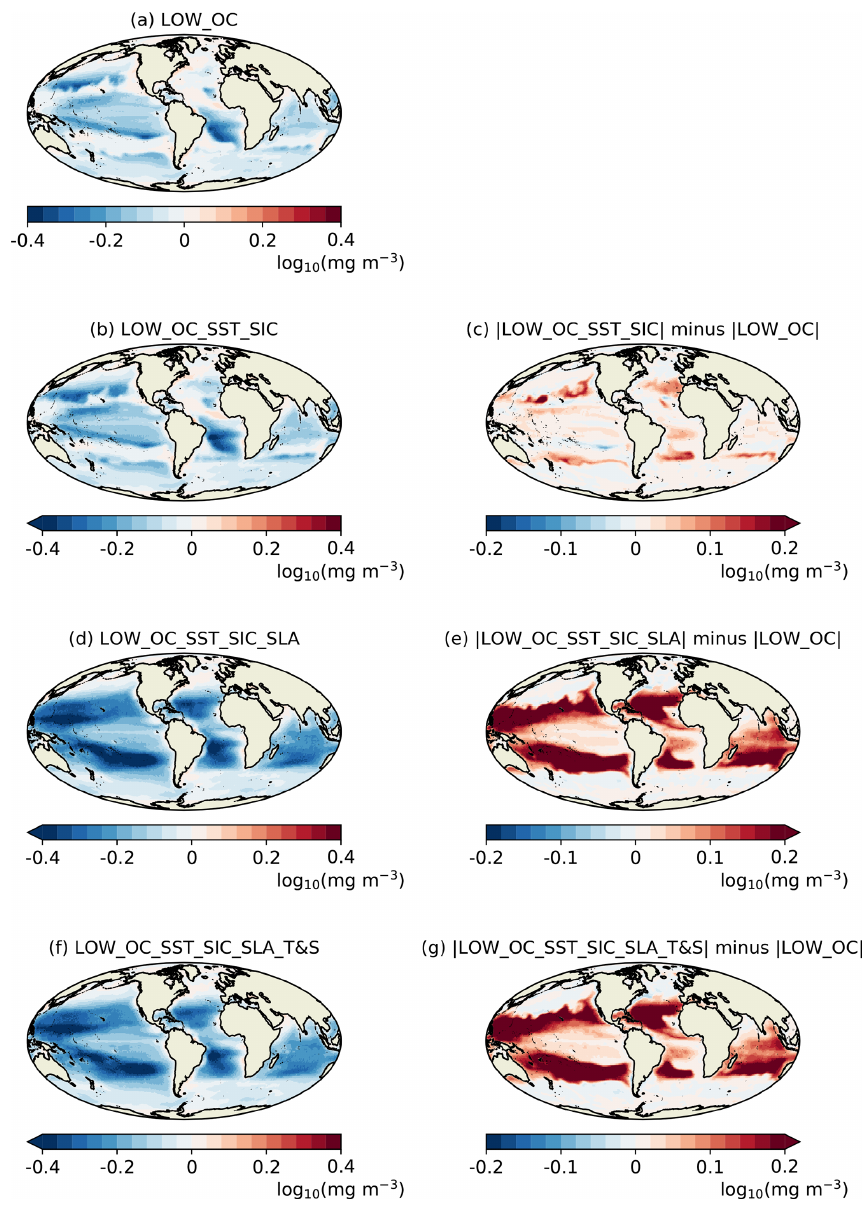
Figure 2. Mean surface log 10 (chlorophyll) assimilation increments for